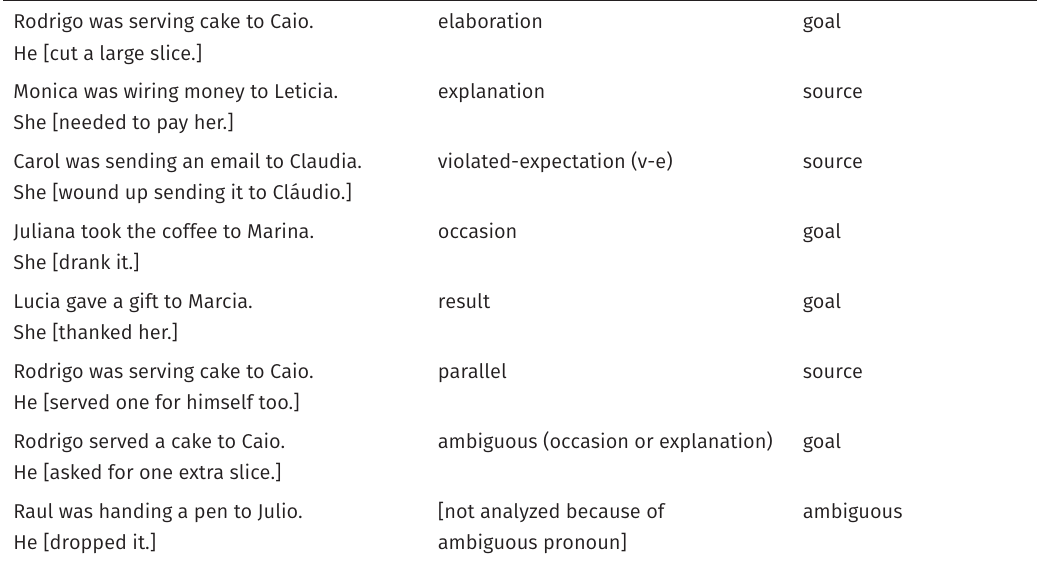
Table 2: Example of annotated